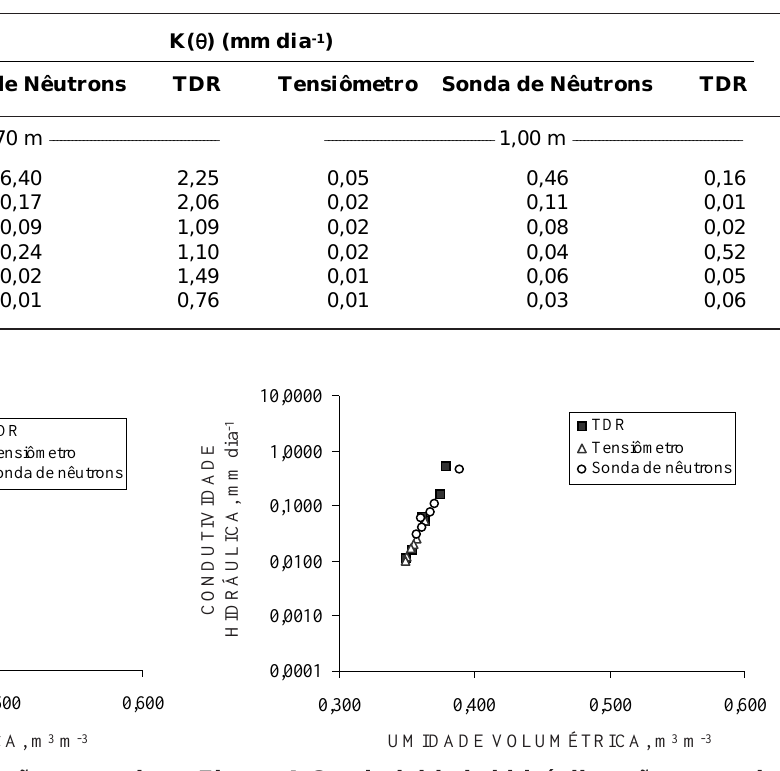
Figura 4. Condutividade hidráulica não saturada, considerando os três equipamentos, para a profundidade de 1,00 m.